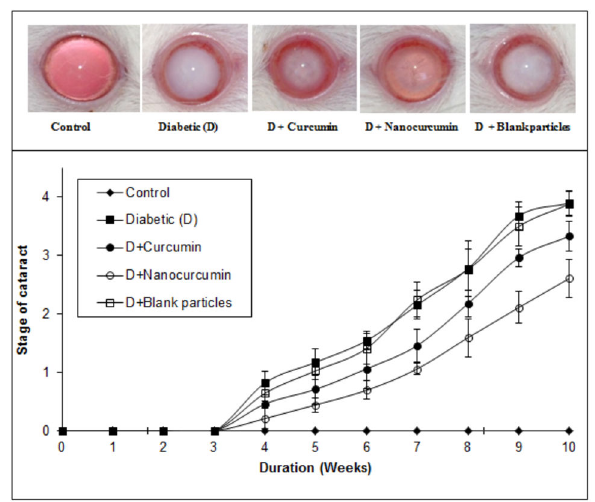
Figure 2. The effect of curcumin and nanocurcumin on STZ-induced cataract in rats. Top panel : Representative photographs of lens from each group at the end of 10 weeks. Bottom panel : Quantitative representation of cataract progression in each group with time. Stage of cataract in each group was averaged at a given time and the average stage of cataract along with standard error was plotted as a function of time. doi: